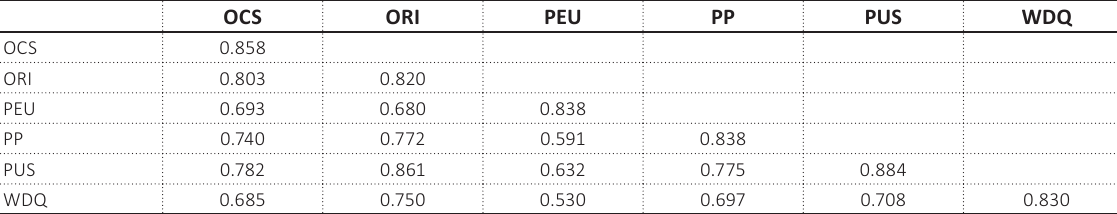
Table 4. Discriminant